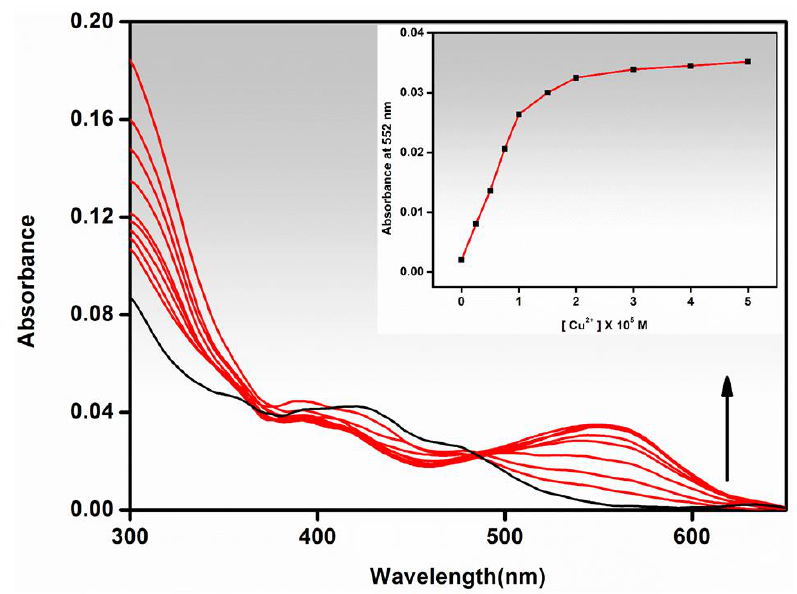
Figure 2. UV–Visible titration of QNH (10 –5 M) in the presence of various concentrations of Cu 2+ . (Upward arrow indicates gradual increase in absorption at 552 nm with increasing concentration of externally added Cu 2+ ). (Inset: absorbance of QNH at 552 nm as a function of [Cu 2+ ]). From the UV–Visible titration result, the limit of detection (LOD = 3 σ /s, where σ is the standard deviation of the blank solution and s is the slope of the calibration curve) [32]